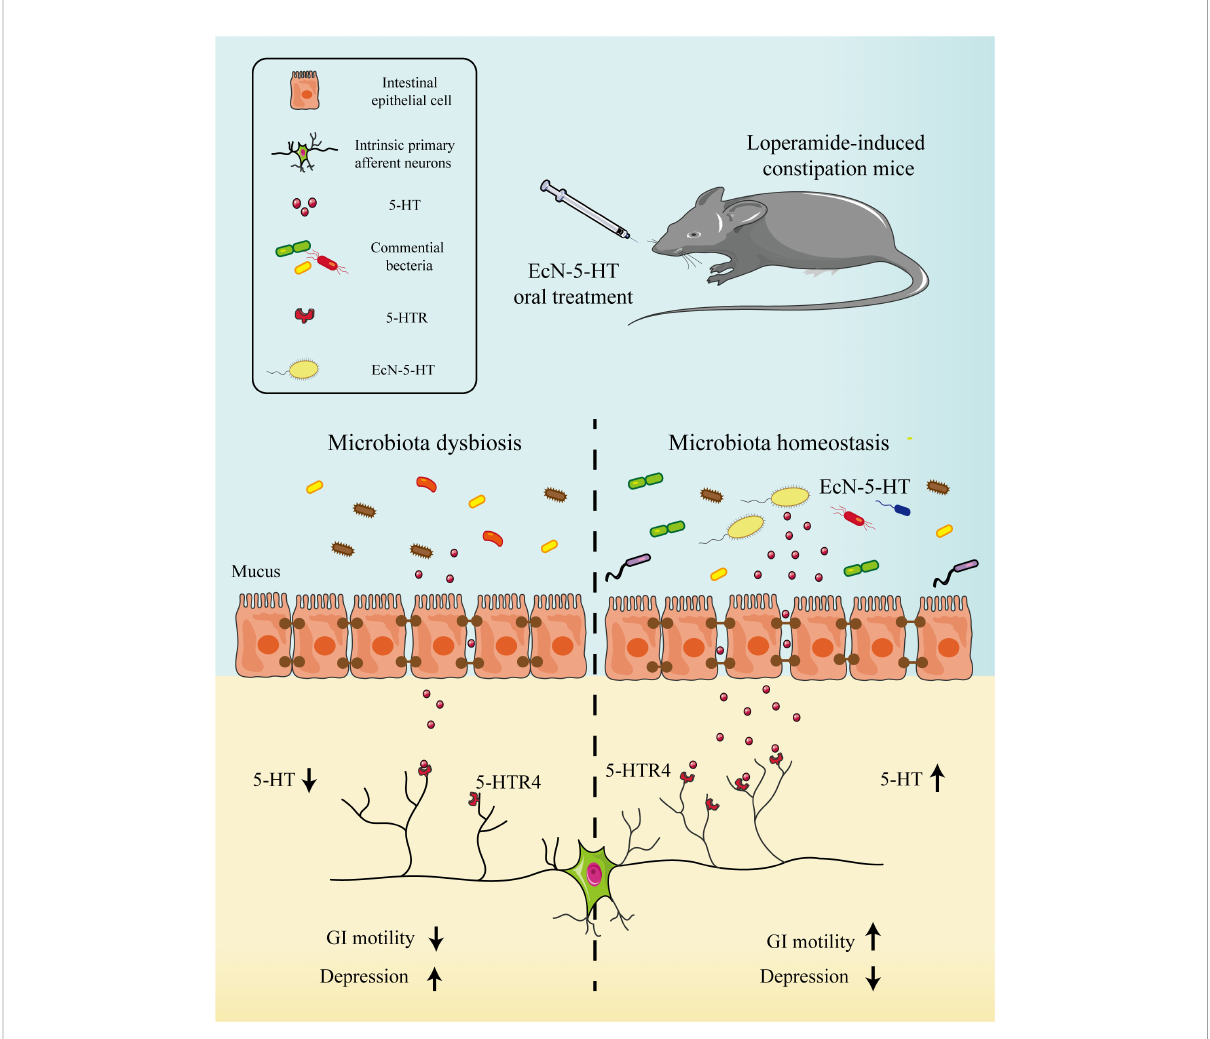
FIGURE 6 EcN-5-HT improved GI motility and ameliorate behavior disorder in loperamide-induced constipation mice model. EcN-5-HT increased the concentration of 5-HT in colon and activated 5-HT receptors, triggering the peristaltic re fl ex in the gastrointestinal tract and promoting the GI motility. Meanwhile, EcN-5-HT modi fi ed the composition of the intestinal microbiota in loperamide-treated